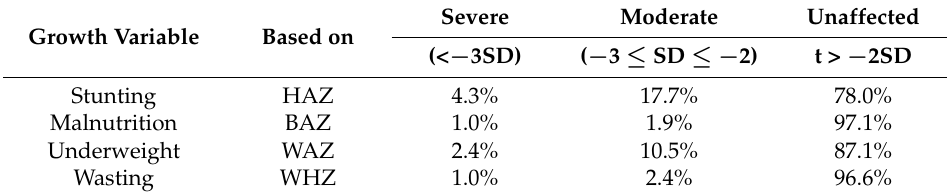
Table 2. Percentage of children in each category of growth parameters as defined by WHO ( n = 209)